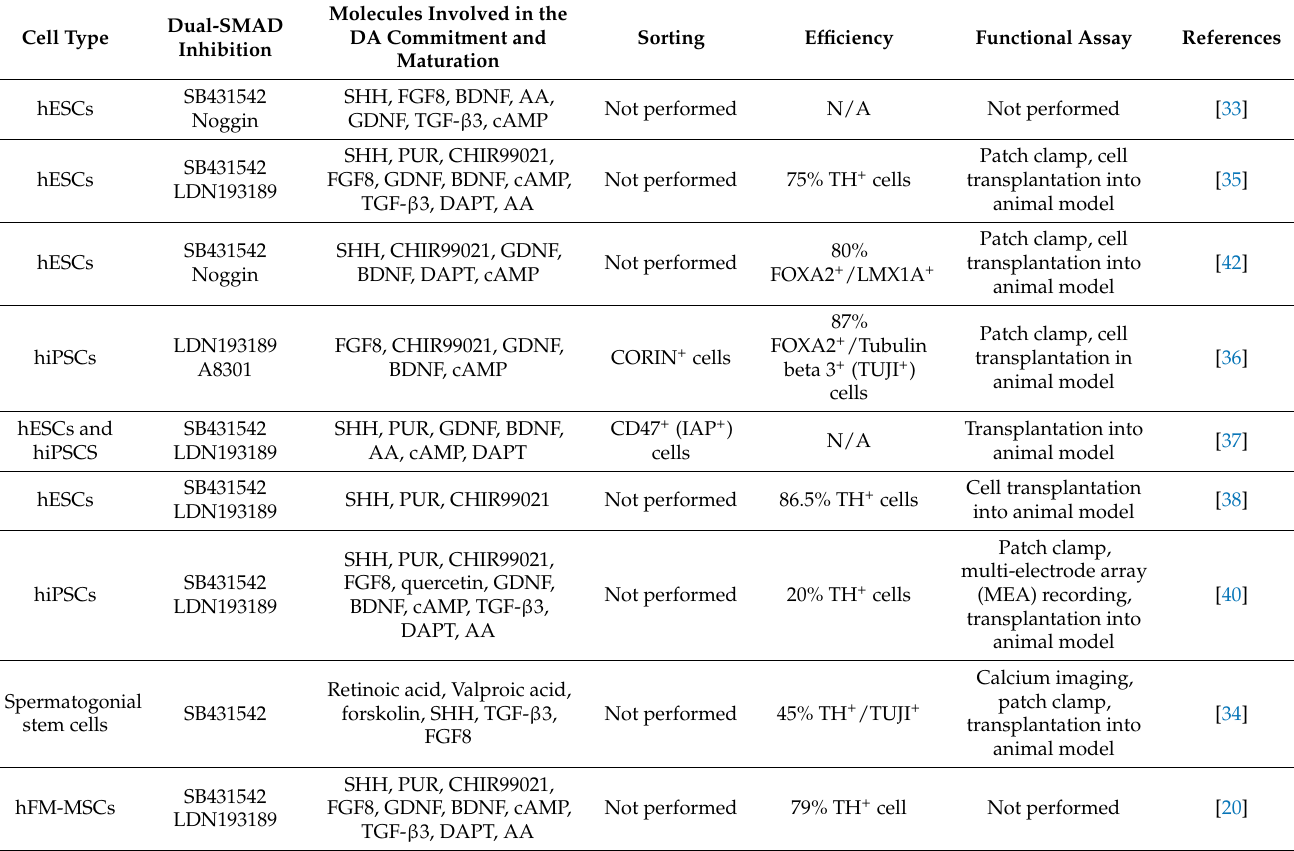
Table 1. Schematic overview of some selected dual-SMAD inhibition-based